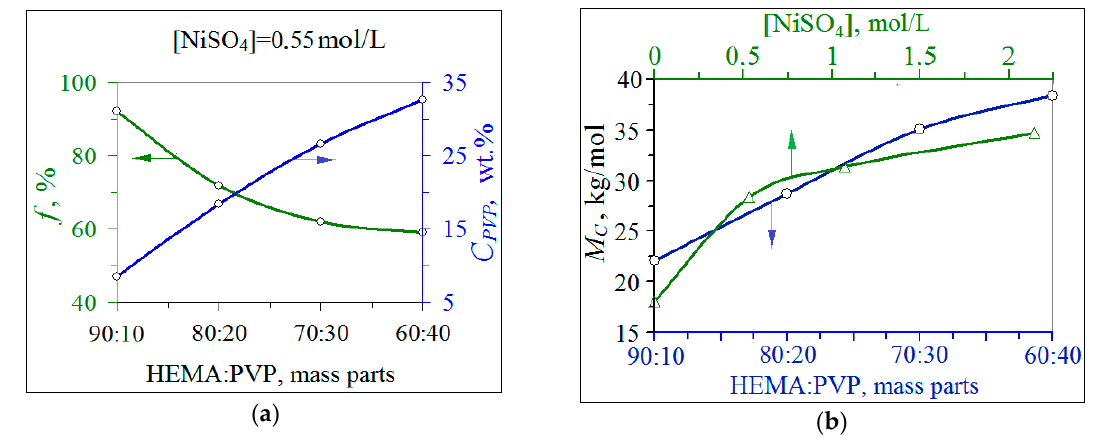
Figure 4. Structural characteristics of Ni / р HEMA-gr-PVP composites: ( a ) – effect of initial polymer–monomer composition (PMC) composition on grafting efficiency ( f ) and polyvinylpyrrolidone (PVP) content in co-polymer ( C PVP ); ( b ) – effect of initial PMC composition ([NiSO 4 ] = 0.55 mol / L) and concentration [NiSO 4 ] in the oxidation-reducing system (ORS) (H ЕМ A:PVP:S ORS = 80:20:50 m.p.) on the molecular weight between cross-links in the polymer network (M C ).